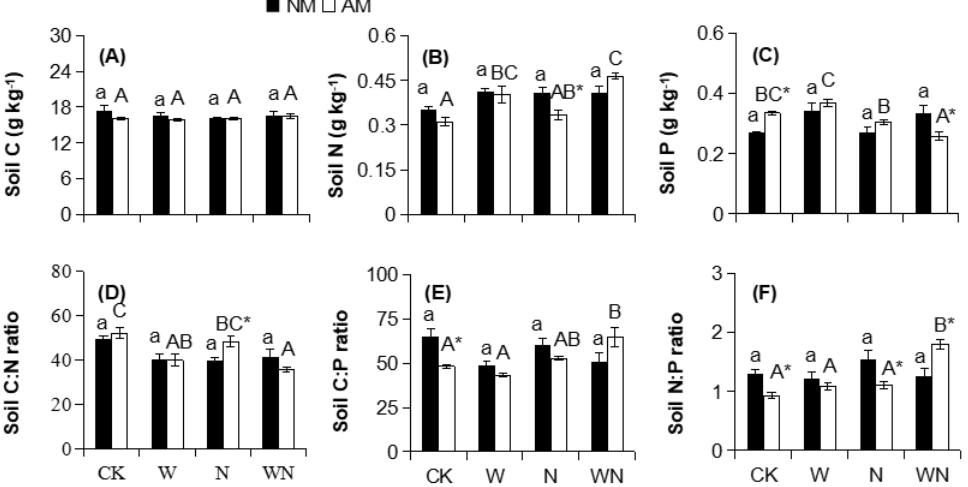
Figure 3. Effects of AMF on soil C ( A ), N ( B ), and P ( C ) contents and C:N ( D ), C:P ( E ), and N:P ( F ) ratios under warming and N input. Different lowercase and capital letters above bars indicate significant differences ( p < 0.05) among different warming and N input treatments within the same AMF treatment. Asterisks indicate significant differences ( p < 0.05) between AMF treatments within the same warming and/or N input condition. CK, control; N, N input; and W, warming; WN, combination of warming and N input.